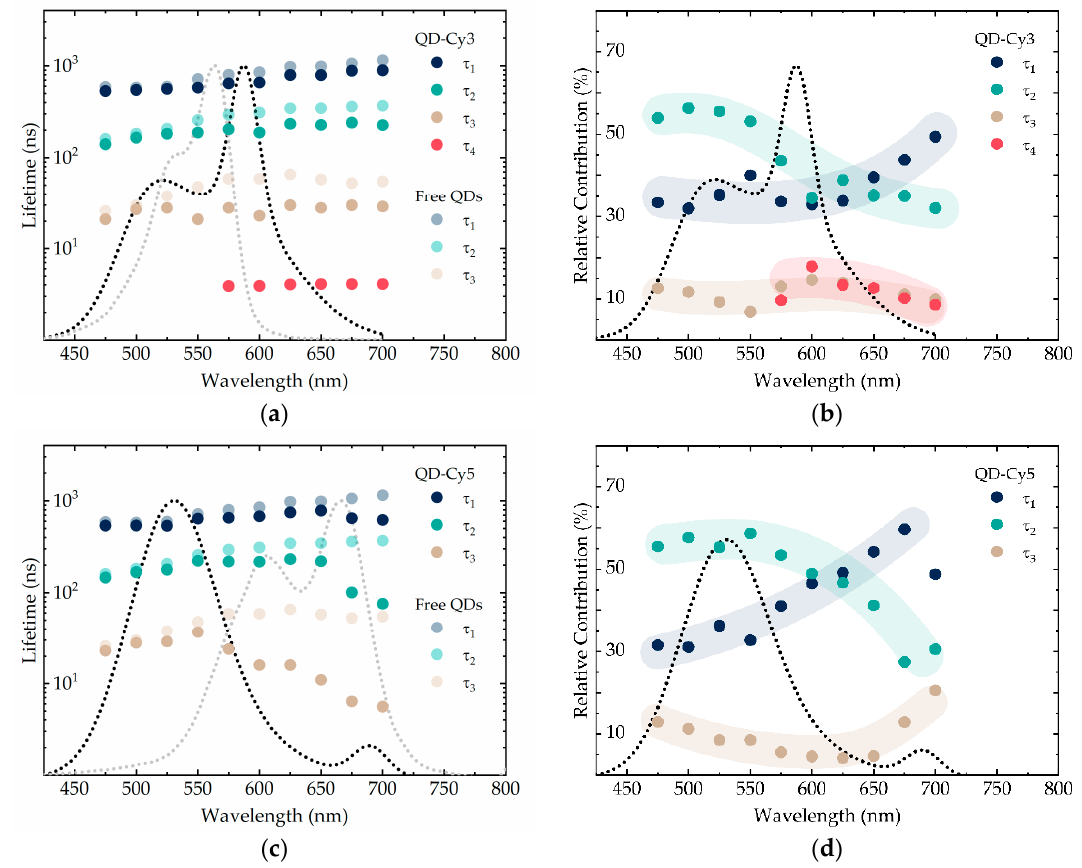
Figure 5. The PL decay components τ 1 , τ 2 and τ 3 ( a , c ) and their relative contributions ( b , d ) for the complexes of AIS/ZAIS/ZnS quantum dots and Cy3 and Cy5 dyes. The PL (black dotted lines) and the absorbance (gray dotted lines) spectra of the corresponding complexes are shown for convenience. The semi-transparent colored lines in ( b , d ) indicate the trend.